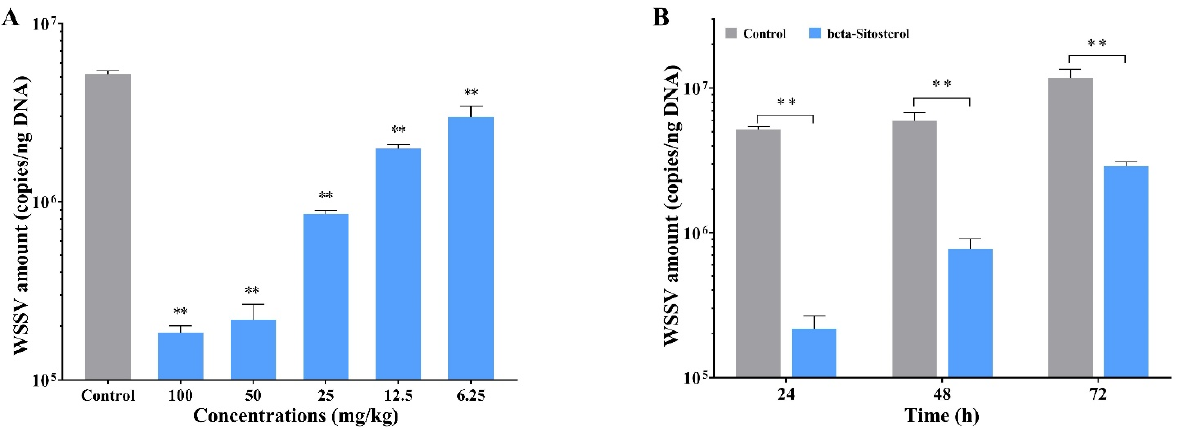
Figure 1. Beta-sitosterol inhibited the replication of WSSV in vivo. The experimental workflow is shown in Figure S3. ( A ) Beta-sitosterol with different concentrations (6.25, 12.5, 25, 50, and 100 mg/kg) had significant inhibitory effects on WSSV replication in crayfish (24 hpi). ( B ) Effects of beta-sitosterol (50 mg/kg) on WSSV replication at 24, 48, and 72 hpi. The data are shown as mean ± SD (n = 5). Asterisks indicate the significant difference between the experimental and control groups (** p < 0.01).